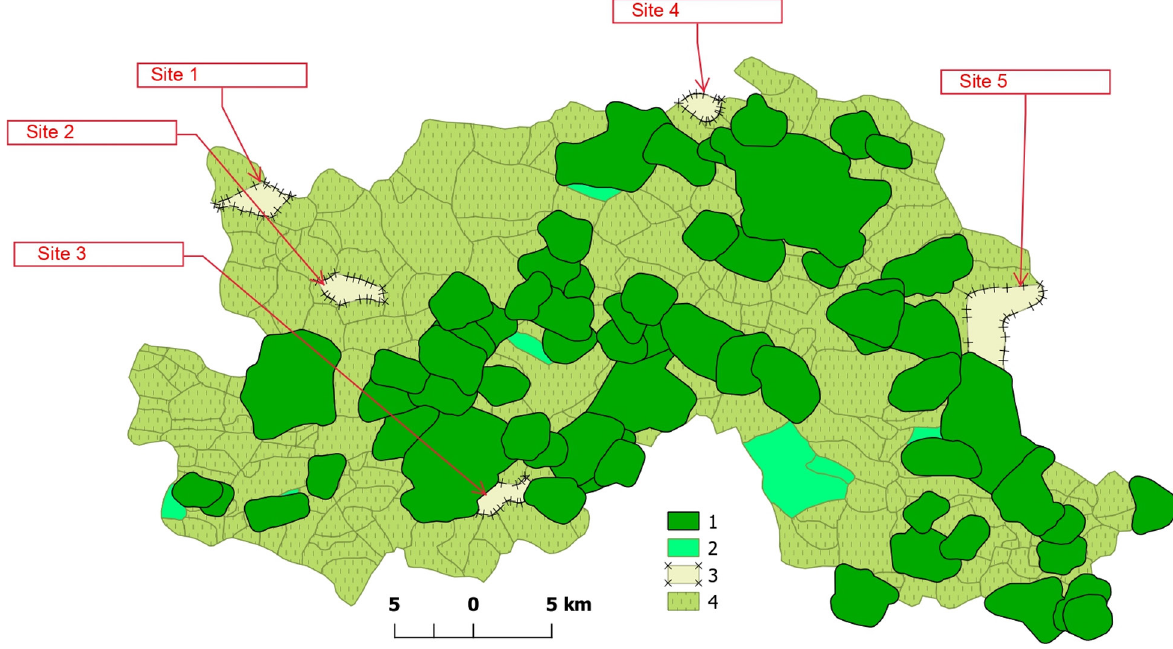
Fig. 7. Map for suggested landfill